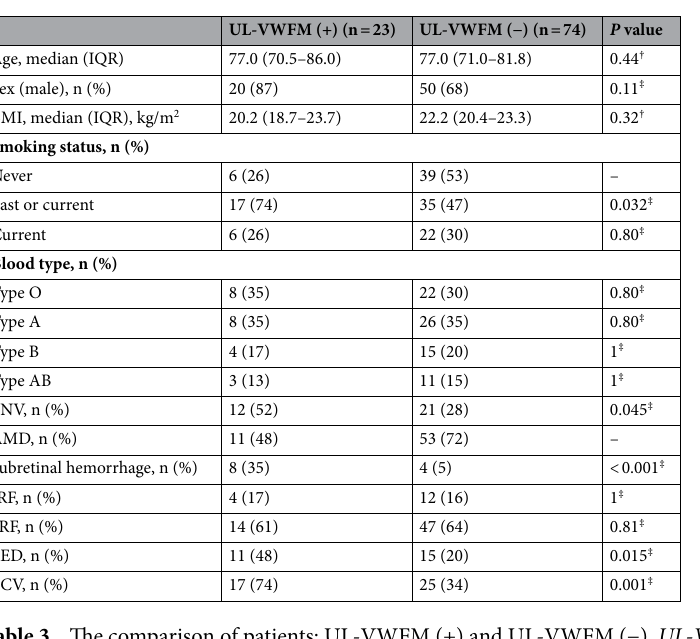
Table 3. The comparison of patients; UL-VWFM (+) and UL-VWFM (−). UL-VWFM unusually large VWF multimer, IQR inter-quartile range, PNV pachychoroid neovasculopathy, AMD age related macular degeneration, IRF intra-retinal fluid, SRF subretinal fluid, PED pigment epithelium detachment, PCV polypoidal choroidal vasculopathy. † Mann–Whitney U test. ‡ Fisher’s exact test.